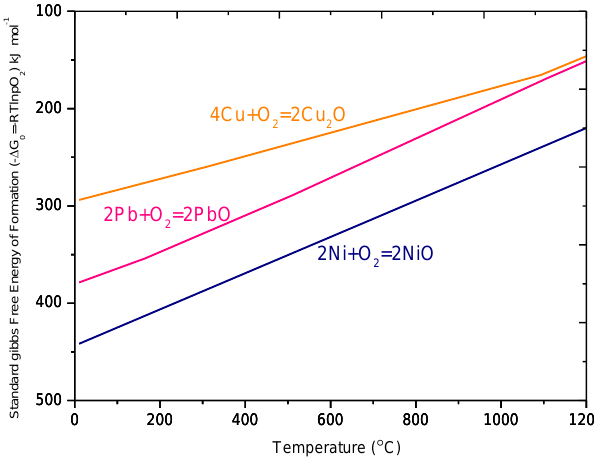
Figure 3. Standard Gibbs formation energy of oxides of Cu, Ni, and Pb, redrawn from [8]. Co-firing the kinetically more readily oxidized copper with PZT is thermodynamically feasible within a narrow pO 2 window. There were published works on co-firing a Cu electrode [37] with PZT- based materials. Takayama et al. [38] reported the work on fabricating Cu co-fired PZT-SKN (PZT- Sr(K 0.25 Nb 0.75 )O 3 ) [20,21,23] multilayer actuators. An acrylic binder system was used to lower the